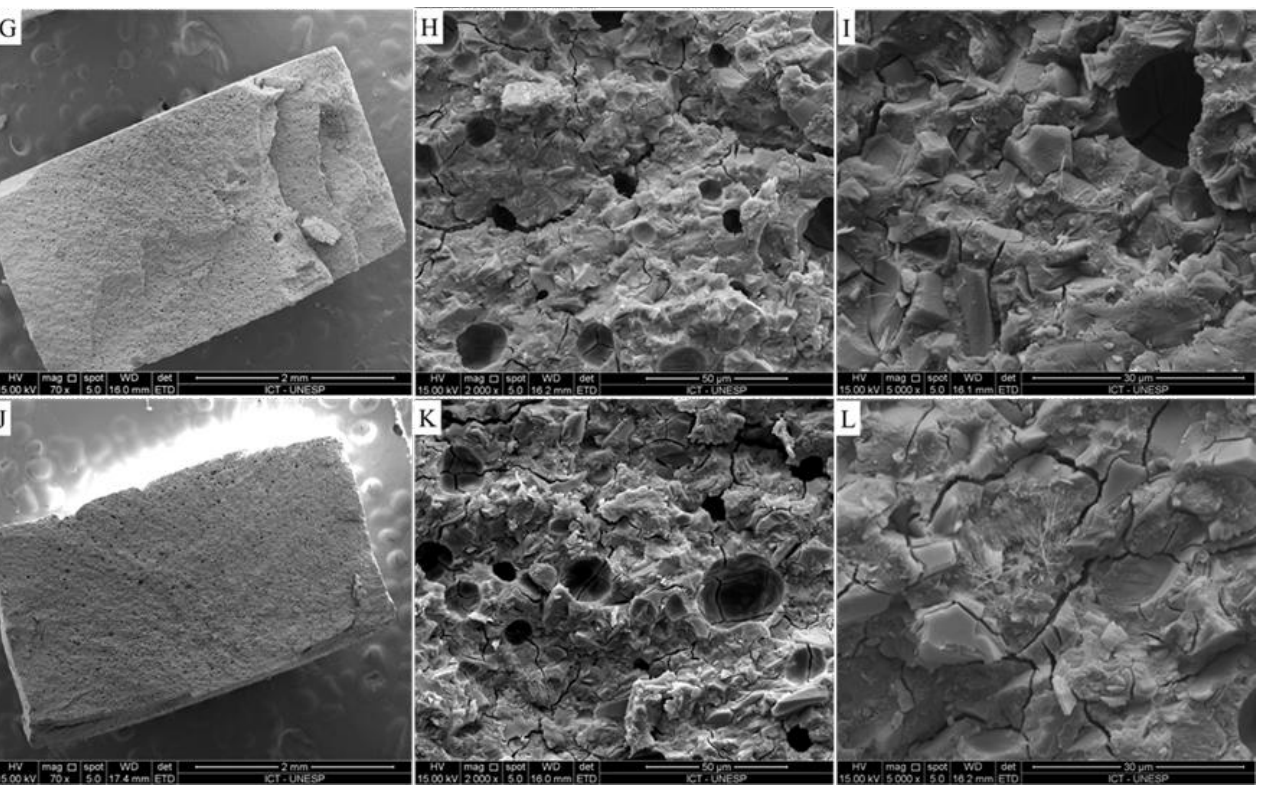
Figure 2. Scanning electron microscopy (SEM) of different specimens after the compressive strength test. ( A – C ) High-viscosity glass ionomer cement without MWCNT incorporation at 70, 1000 and 5000× magnification; ( D – F ) high-viscosity glass ionomer cement with MWCNT incorporation at 70, 1000 and 5000 × magnification; ( G – I ) conventional glass ionomer cement without MWCNT incorporation at 70, 1000 and 5000 × magnification; and ( J – L ) conventional glass ionomer cement with MWCNT incorporation at 70, 1000 and 5000 × magnification. Yellow arrows indicate the presence of small cracks between the GIC particles.